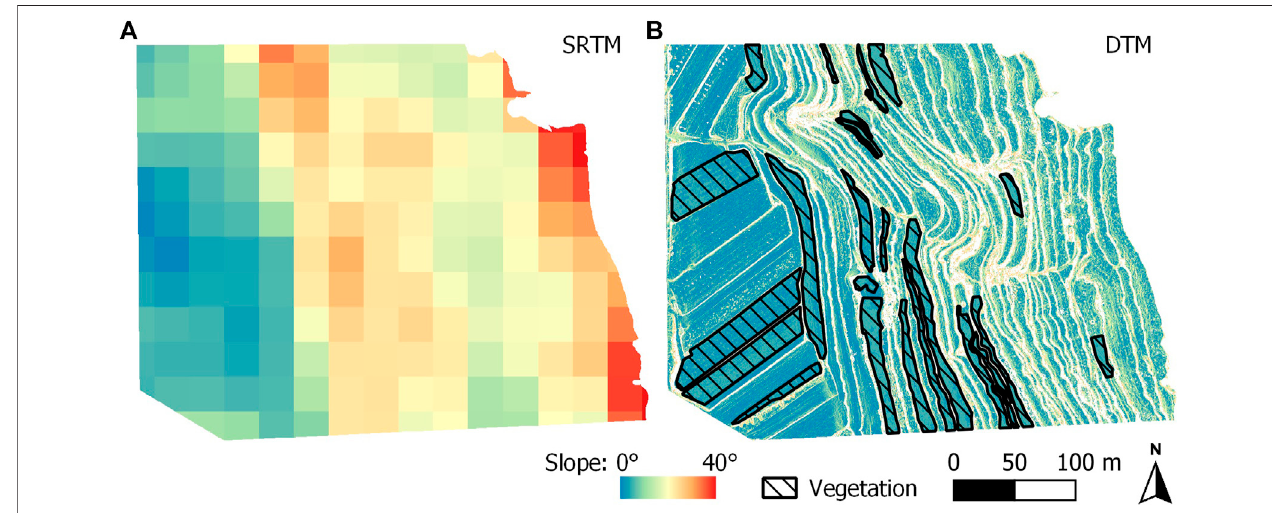
FIGURE 4 | Two DTMs of the study area generated from SRTM and UAV-imagery. (A) The DTM was based on Shuttle Radar Topography Mission from the US Geological Survey. (B) the DTM was based on imagery obtained by unmanned aerial vehicle.